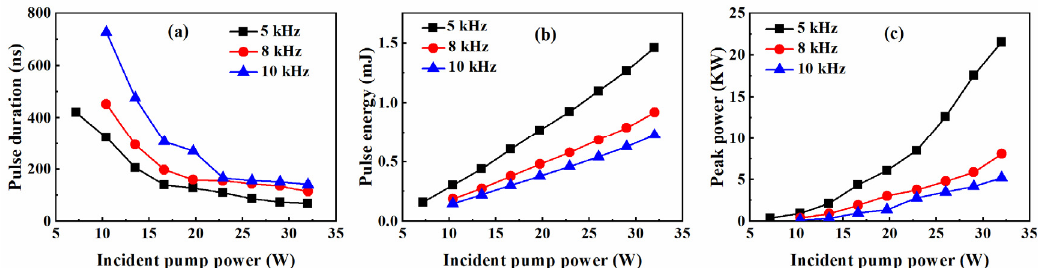
Figure 3. Experiment results for the AO Q-switched Tm:YLF laser: ( a ) pulse durations, ( b ) pulse energies and ( c ) peak powers versus the incident pump powers.